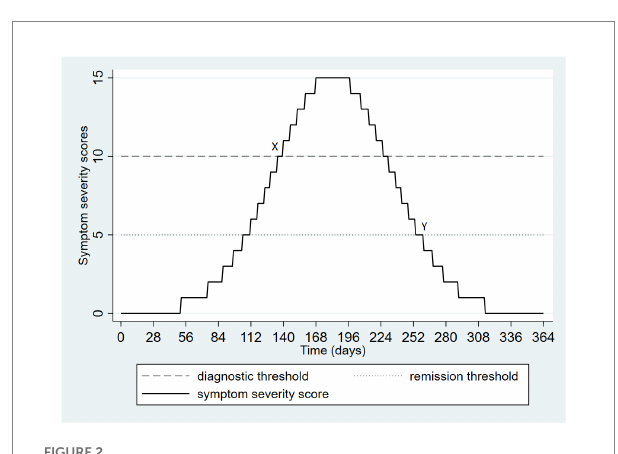
FIGURE 2 Hypothetical pattern of symptom severity over one year, depicting the onset and remission of a single